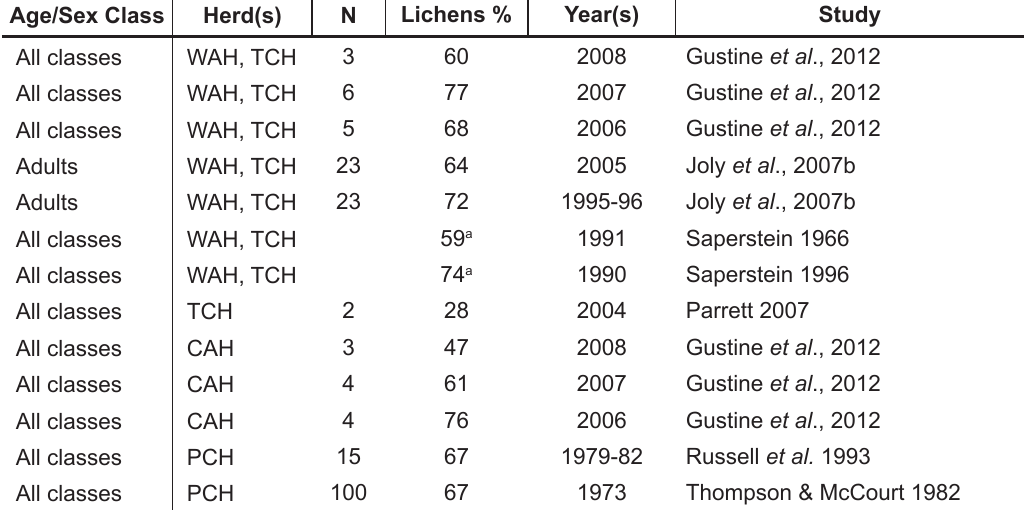
Table 1. Percentage of lichens in the late winter diet of ‘arctic’ caribou reported from other projects. WAH is Western Arctic Herd, TCH is Teshekpuk Caribou Herd, CAH is Central Arctic Herd, and PCH is Porcupine Caribou